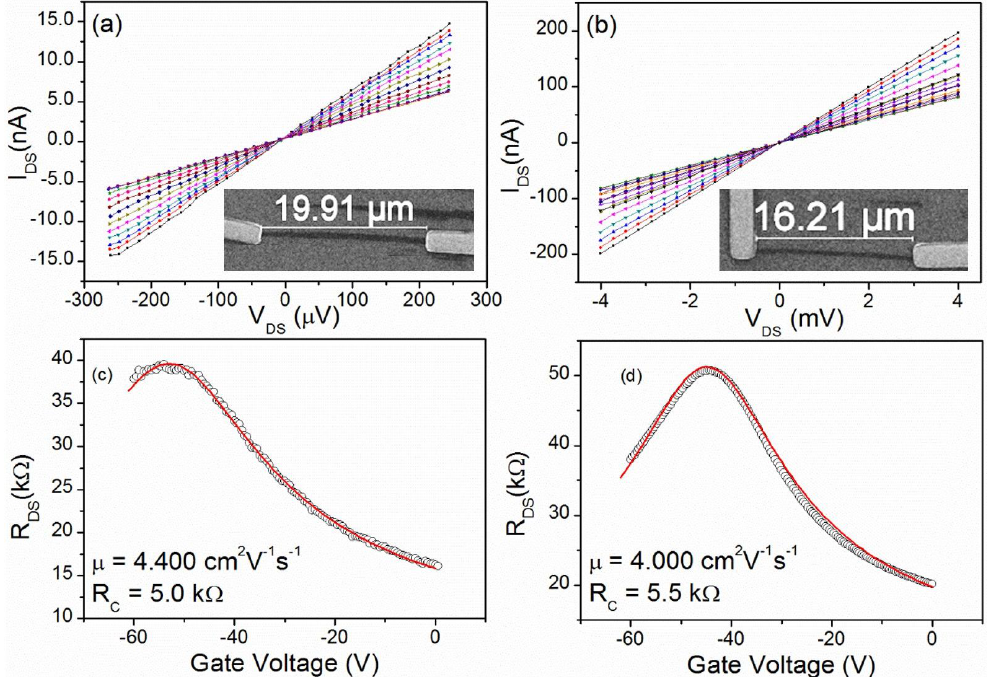
Figure 3. Electrical characterization under a high vacuum of two devices produced on the same substrate. ( a , b ) I DS vs. V DS curves for the devices shown in the insets with dimensions 19.9 µm × 0.7 µm and 16.2 µm × 0.3 µm, respectively. Curves are measured for different gate voltages in the range −60 V < V Gate < 0 V with steps of 5 V. ( c , d ) R DS vs. V Gate curves measured at V DS = 1 mV for the devices of Figure 3a,b, respectively. The solid (red) lines are the fitted model of [32] with the parameters listed in the